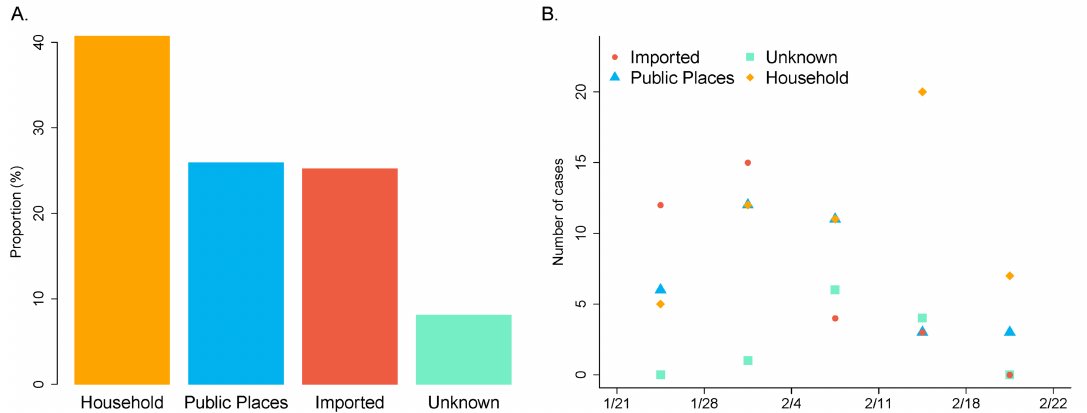
Figure 1. Case information in Tianjin (totally 135 cases, reported from 21 January to 26 February). ( A ) Proportion of cases infected in different ways/places. ( B ) Chronological development of the infection by transmission ways/places.